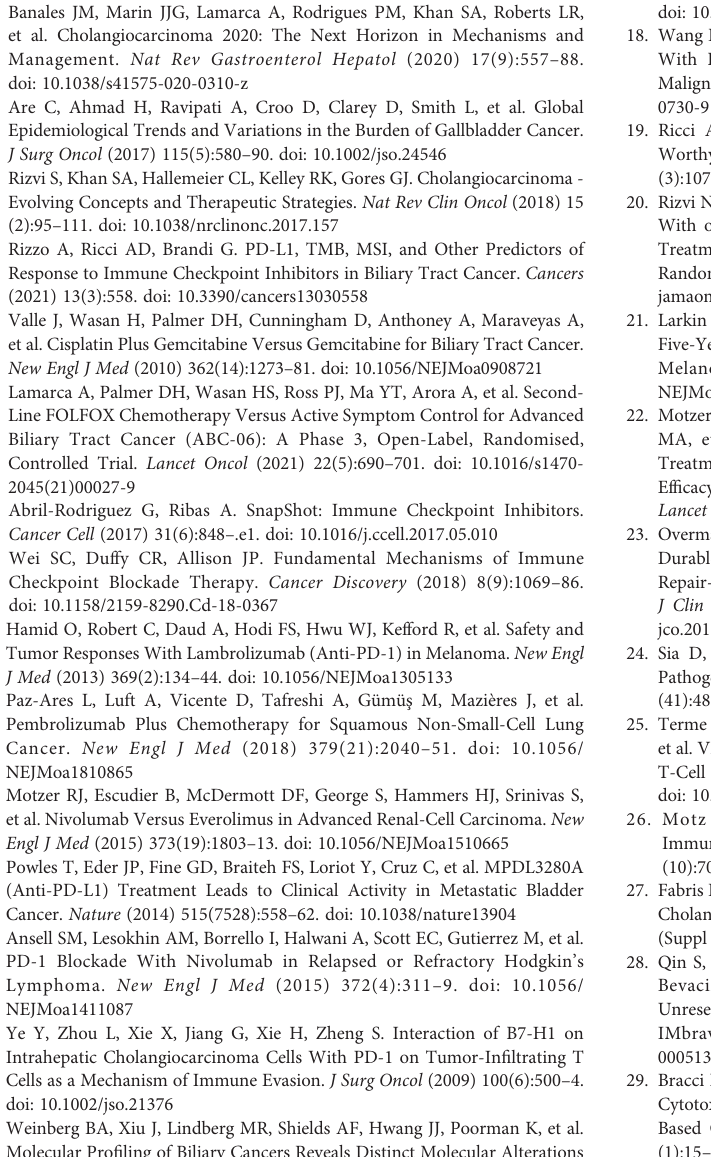
Supplementary Figure 1 | Funnel plots depicting the publication bias in included studies. (A) ORR of total group; (B) DCR of total group; (C) CR of total group; (D) PR of total group; (E) SD of total group; (F) ORR of anti-PD1-containing regimens; (G) ORR of second line therapy or beyond; (H) DCR of second line therapy or